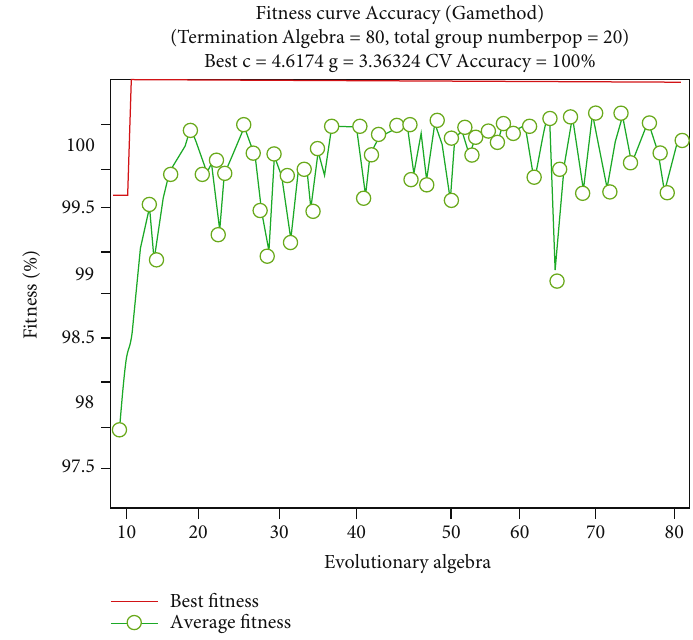
Figure 5: The changing trend of the fi tness function values of the two